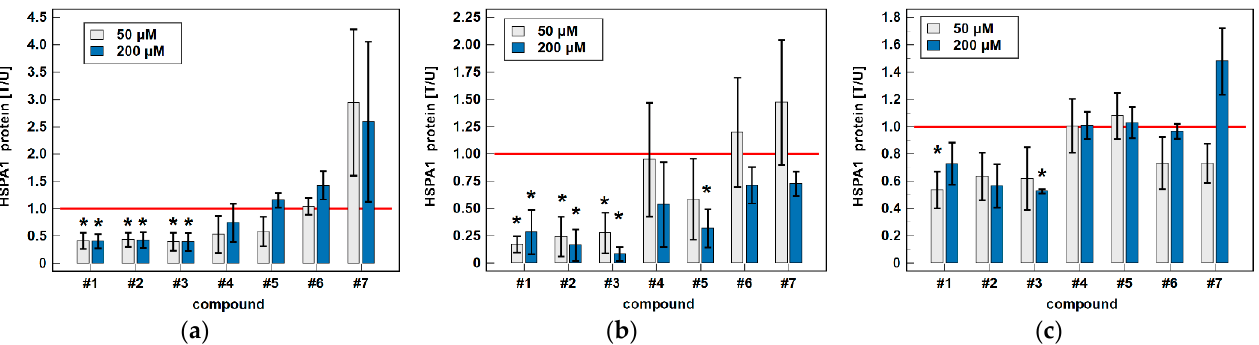
Figure 5. Effect of oxicams on HSPA1 protein expression in colorectal adenocarcinoma cell lines: ( a ) Caco-2; ( b ) HCT 116; ( c ) HT-29. Data presented as means ± SEM ( n = 3) of normalized expression in treated against untreated cells [T/U] and analyzed using t -test for one mean. Statistical significance ( p < 0.05) is indicated by asterisks (*) and protein expression in control (untreated) cells is indicated by horizontal red solid line. Cells were treated with 50 µM or 200 µM oxicams for 48 h. Compound #6 denotes piroxicam and #7—meloxicam.